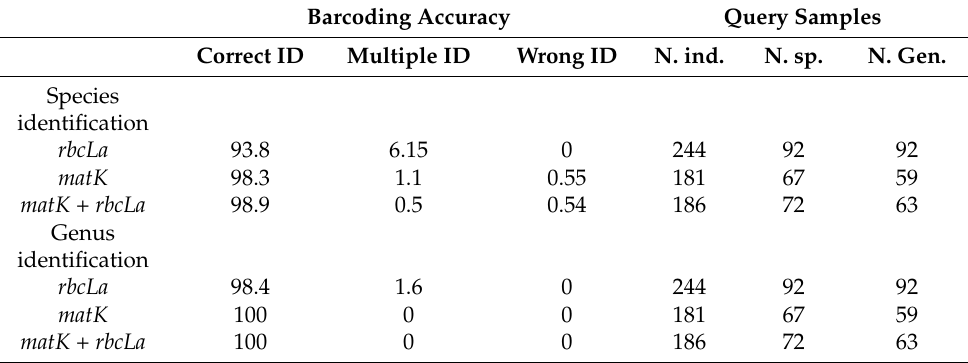
Table 2. Barcoding accuracy in identifying Ngel Nyaki Afromontane forest trees at species and genus level. Barcoding Accuracy Query Samples Correct ID Multiple ID Wrong ID N. ind. N. sp. N.